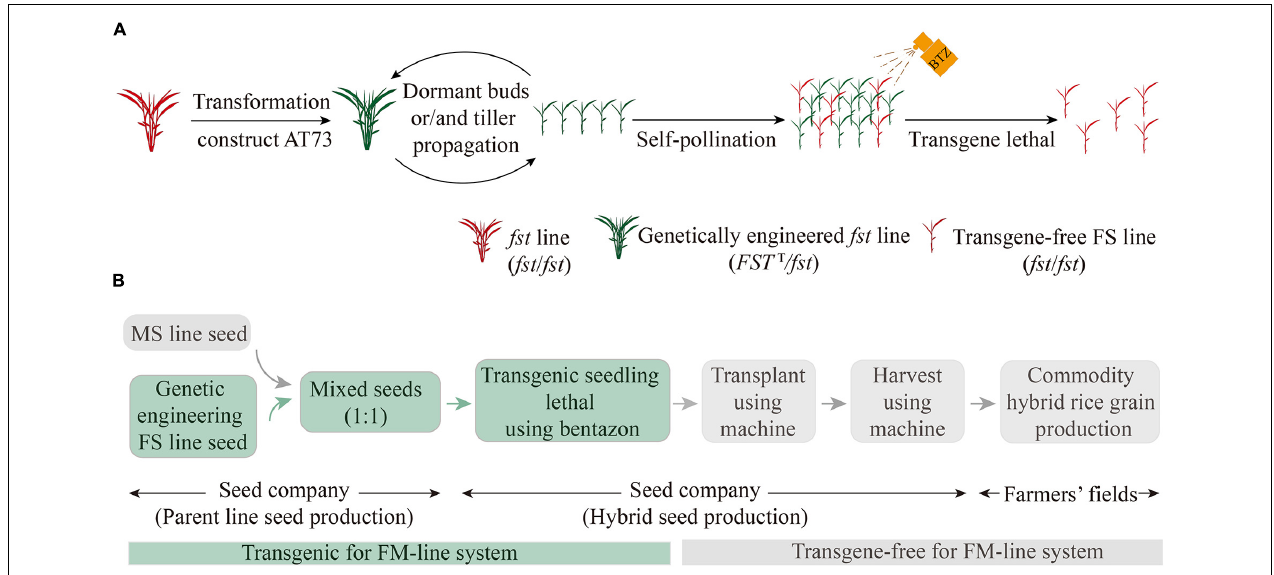
FIGURE 5 | Schematic representation of the FM-line system process for the mechanization of HRS production. (A) The genetically engineered FS system to propagate transgene-free FS lines. The red-colored plants are non-transgenic or transgene-free; the green-colored plants are transgenic. (B) The FM-line system for mechanized HRS production. HRS, hybrid rice